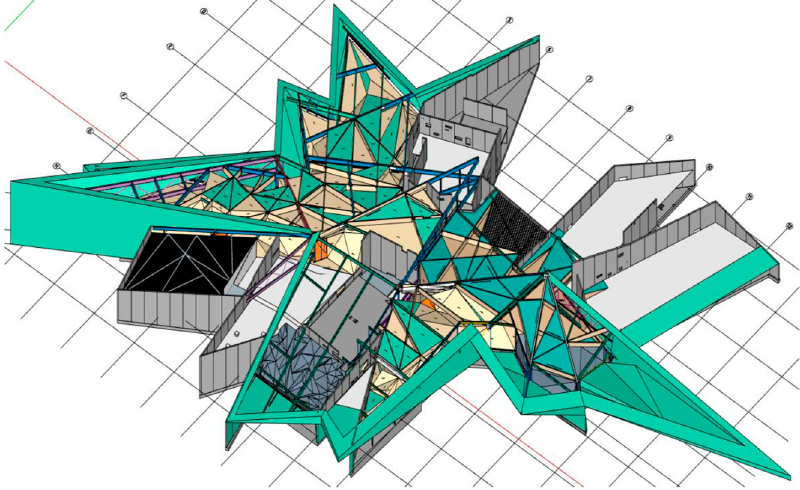
Figure 1. Building Information Model of Builder C3 (Adapted from Phillip Island Nature Parks, 2022).